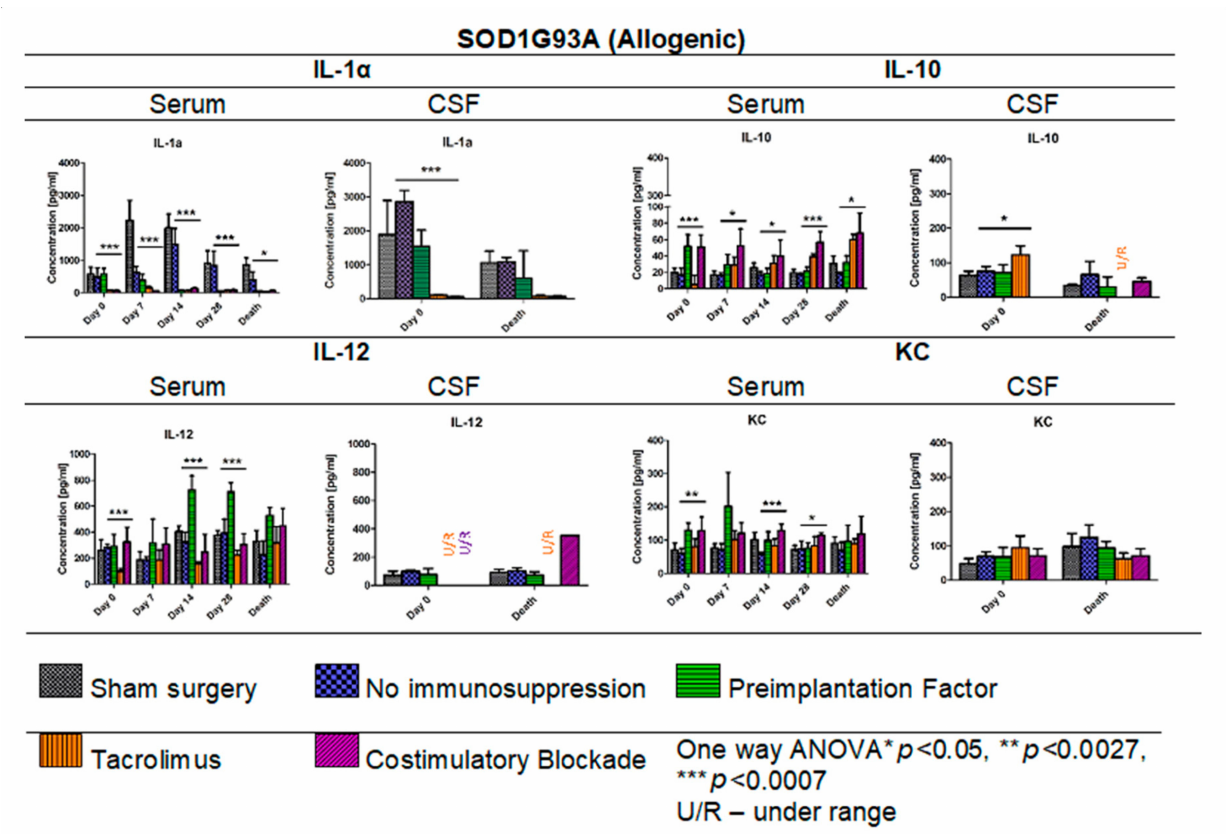
Figure 14. Cytokine levels in serum and CSF samples in ALS SOD1G93A allogenic mouse model: IL-1 α , IL-10, IL-12, and KC levels in serum and CSF samples were measured in allogenic ALS SOD1G93A mice. There was a striking difference in IL-1 α levels in no immunosuppression and sham surgery variants and variants in which immunosuppressive versus immunomodulatory regimens were applied. Significant differences were also seen in IL-10, IL-12, and KC levels in serum samples and IL-1 α and IL-10 levels in CSF samples on day 0. No significant differences were found in IL-12 and KC levels in the course of observations. Moreover, no significant differences on the day of termination for IL-1 α and IL-10 levels were found. However, it is worth emphasizing that the levels of IL-10 and IL-12 in the Tacrolimus and co-stimulatory groups were undetectable in CSF. Information about other cytokines levels from the 23-cytokine mouse panel is accessible in Supplementary Figures S1–S3. Unpaired Student’s t -test; data are presented as mean, error bars: SD; the total number of samples: n = 101, total number per variant at each time point: n = 2–6. The total number of biological replicates per group: n = 6. Abbreviations: ALS-amyotrophic lateral sclerosis; CSF-cerebrospinal